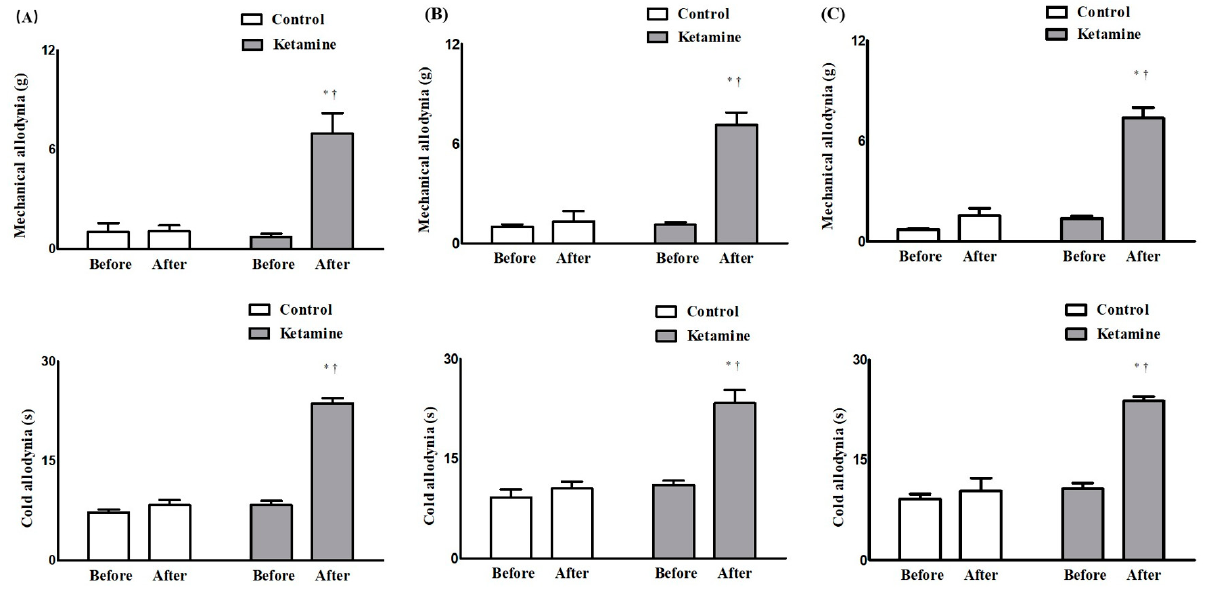
Figure 2. Assessment of allodynia for neuropathic pain at the ipsilateral side for the surgery before and after the treatment of ketamine or normal saline on 15 days ( A ), 18 days ( B ), and 21 days ( C ) after the surgery. * p < 0.05 compared with before treatment. † p < 0.05 compared with the control group.